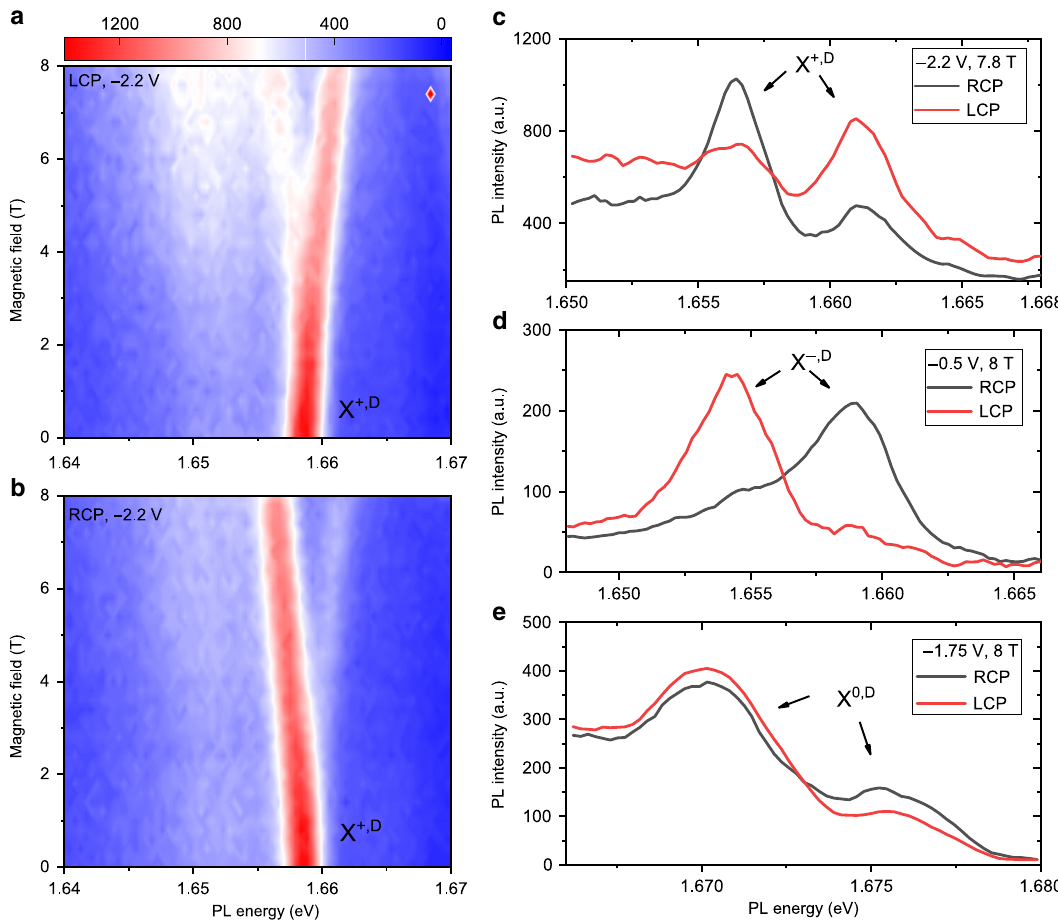
Fig. 3 Resolving the valley degree of freedom of dark excitons by the Zeeman shift. a , b Contour plot of the PL spectrum of the OP channel as a function of magnetic fi eld for a hole doped WSe 2 sample (both gates at − 2.2 V). a is for the LCP excitation and b for the RCP excitation. The color bar represents the PL intensity. c – e PL spectra of the OP channel under RCP (black line) and LCP (red line) excitation. The out-of-plane fi eld is about 8 T. The gate voltages − 2.2 V ( c ), − 0.5 V ( d ), and − 1.75 V ( e ) correspond to a hole-doped, electron-doped, and neutral sample,